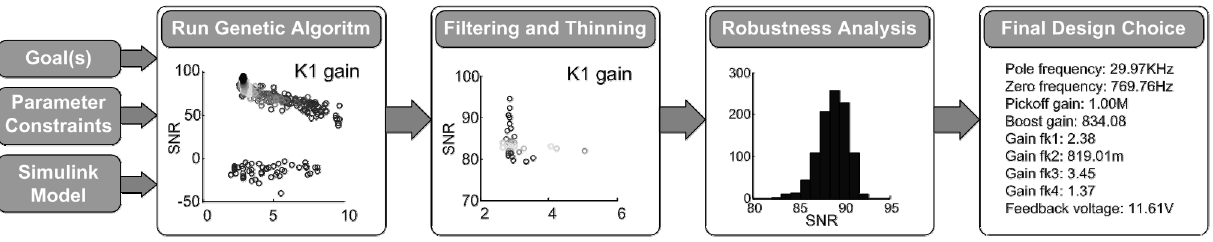
Figure 2. Generic process flow for the GA-based design